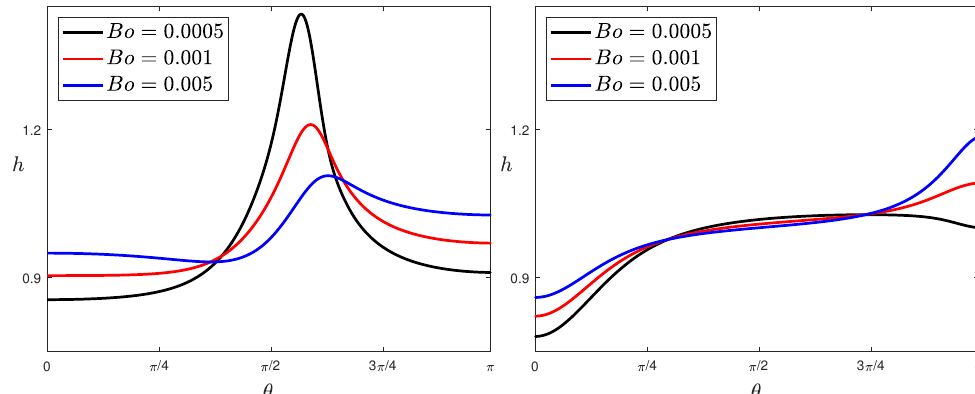
Figure 7. Variations in the steady thickness profiles for the fixed angular velocity Ω d = 0.03, where the Bond number is Bo = 5 × 10 − 4 ,10 − 3 ,5 × 10 − 3 . ( left ) Oblate spheroid γ = 0.5; ( right ) Prolate spheroid γ = 2.